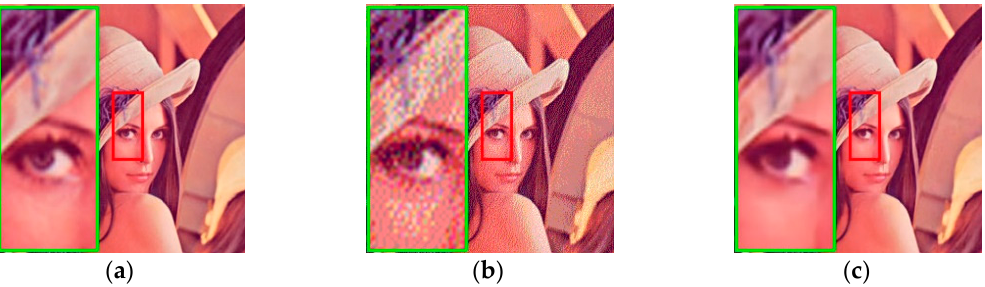
Figure 1. An illustration of halftoning and inverse halftoning, where the region of red box in each image is enlarged and overlapped on the left part of each image: ( a ) continuous-tone image, ( b ) halftone image, ( c ) restored image from ( b ).